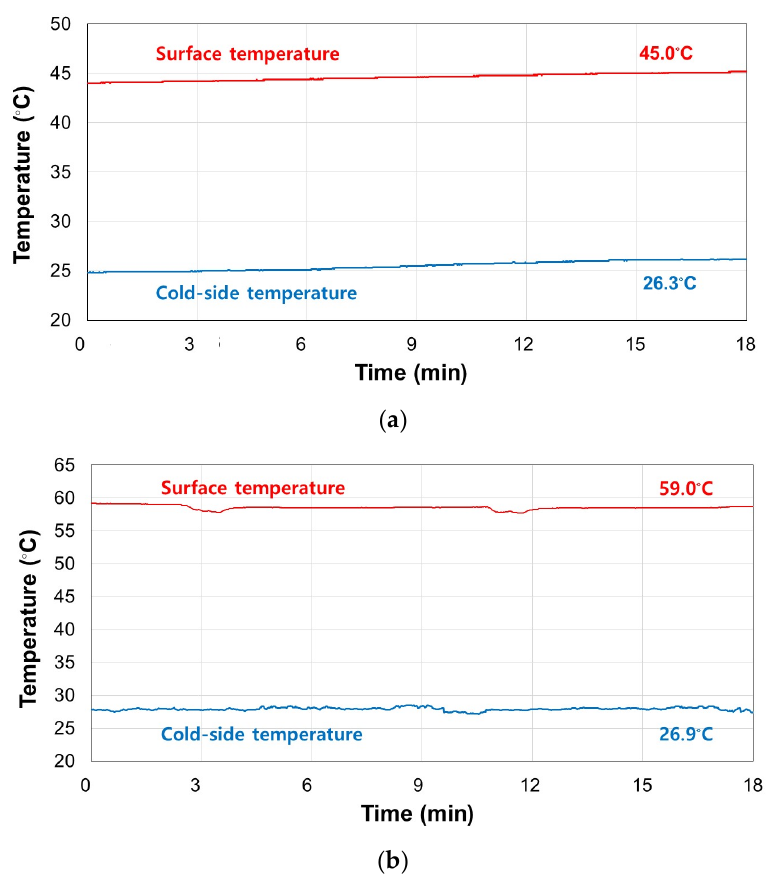
= 45 ◦ C and ( b ) T = 60 ◦ surf surf